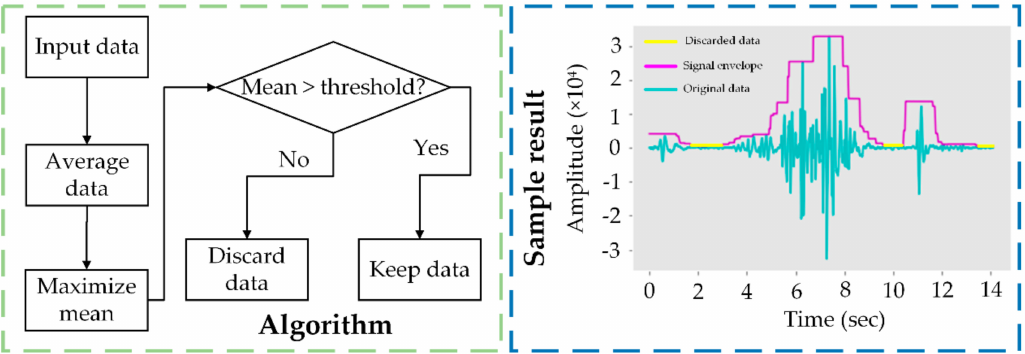
Figure 5. Illustration of the algorithm for uninformative data removal ( left ) and a sample result with a signal envelope after uninformative data removal ( right) . The amplitude values are in 16 bits and